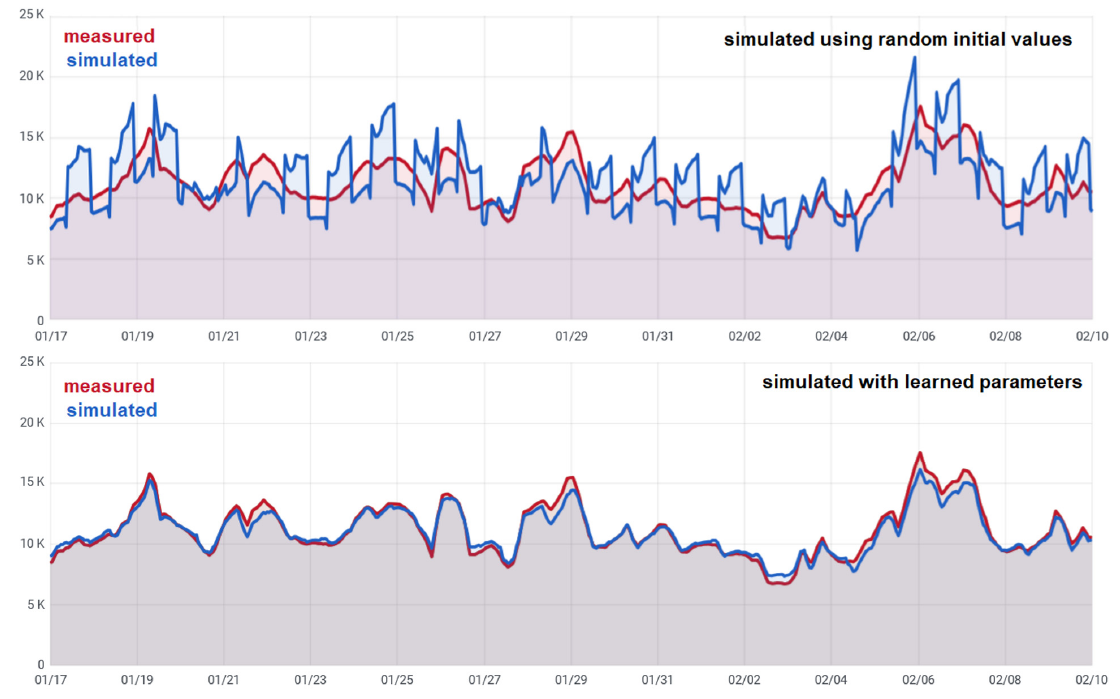
Figure 3. GA-based learning of building model (baseline parameters). Table 2. The success of the identification